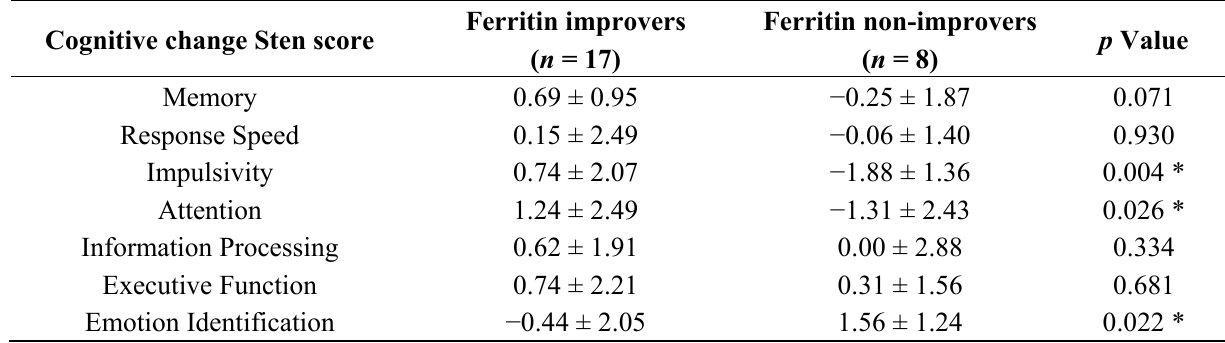
Table 3. Cognitive domain change scores for ferritin improvers and